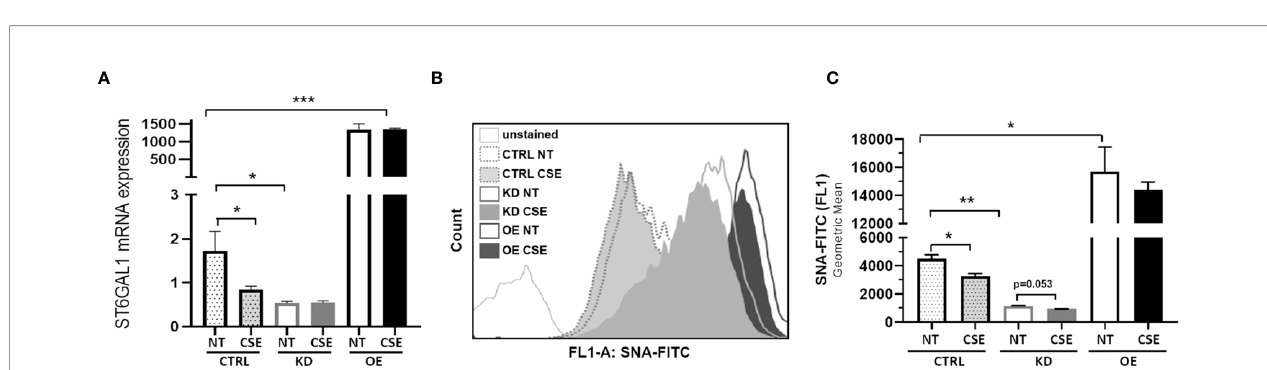
FIGURE 1 | Reduced extracellular sialylation in HBEs following 3, 6 and 15-day CSE exposure. (A) Relative mRNA expression of ST6GAL1 at times indicated without (CTRL) and with cigarette smoke extract (CSE). (B – D) Flow cytometric histogram showing levels of a 2-6 sialylation for HBECs cultured for 3, 6, and 15 days without (CTRL) and with (CSE). Ten thousand events were collected for each group, analyzed by SNA-FITC staining, and shown as the geometric mean of the values. Experiments were performed in triplicate and three separate experiments. SNA, Sambucus Nigra Lectin; and CSE, cigarette smoke extract. All bar graphs are means ± SEM with *p < 0.05.